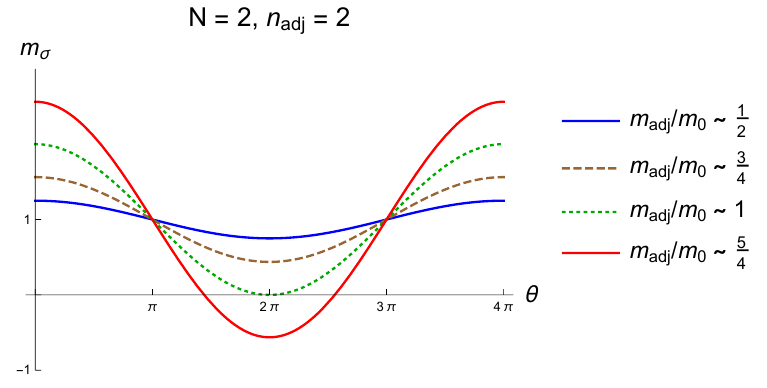
Figure 5 . [Color Online.] A sketch of the (cid:18) angle dependence of the dual photon mass m (cid:27) in SU(2) adjoint QCD with n adj = 2 (cid:13)avors of adjoint Majorana fermions in the k = 0 (cid:18) -vacuum, as a function of the fermion mass m adj in units of the mass gap at vanishing adjoint quark mass, m 0 (cid:24) m W e (cid:0) S 0 . For small enough fermion mass, the (cid:18) -dependence is very mild, in the sense that the k = 0 (cid:18) -vacuum is stable for all (cid:18) . The dual photon mass is normalized to its value in the chiral limit. But once m adj exceeds m 0 , the (cid:18) -dependence becomes more dramatic: there is a region where the k = 0 vacuum becomes locally